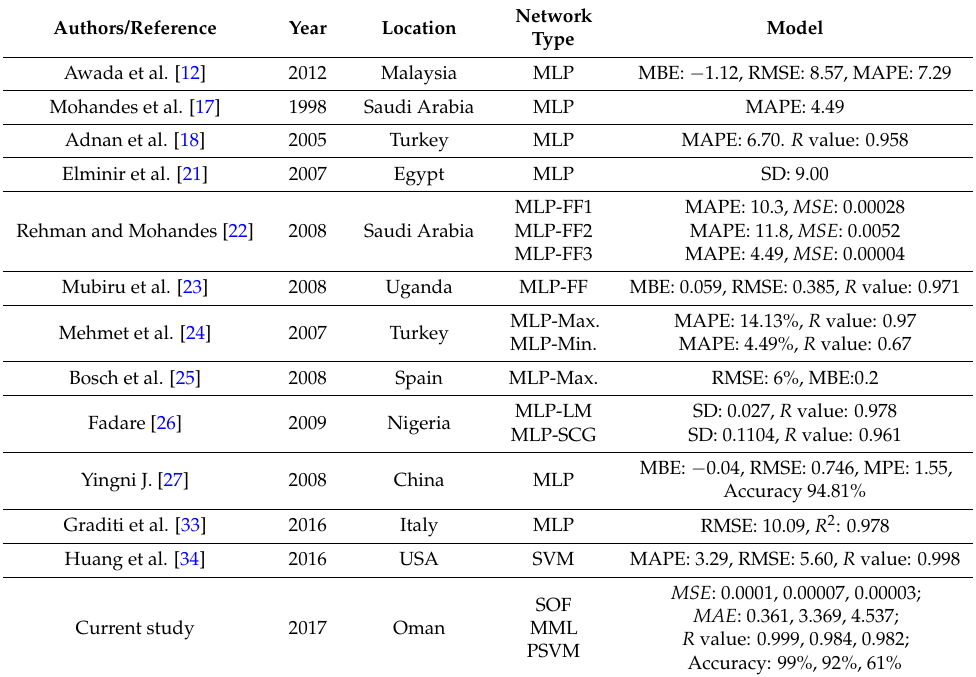
Table 3. Comparison of production accuracy